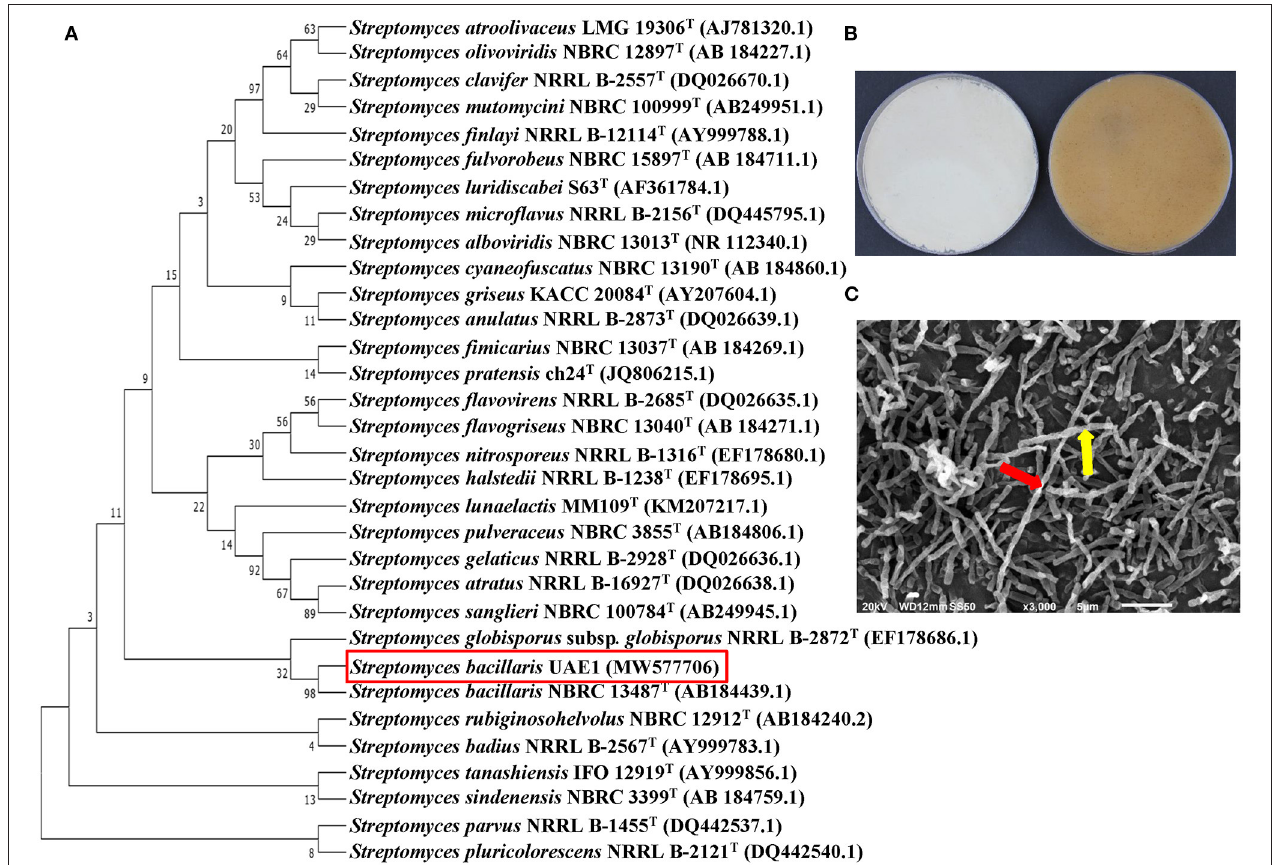
FIGURE 2 | Taxonomic identification of the PAs-producing Streptomyces bacillaris ( Sb ) UAE1. (A) The dendrogram showing the phylogenetic relationships between Sb UAE1 (isolate #6; MW577706) and other members of Streptomyces spp. based on 16S ribosomal RNA (rRNA) sequences. (B) Yellow aerial (left) and yellowish-brown substrate (right) mycelia growing on ISP3 medium supplemented with yeast extract; and (C) scanning electron micrograph (3,000X) of long and rectiflexibiles spore chains (red arrow) and smooth-surfaced spores (yellow arrow) of Sb UAE1. In (A) , numbers at nodes indicate the percentage levels of bootstrap support based on a neighbor-joining analysis of 500 resampled data sets. GenBank accession numbers are given in parentheses. PAs,